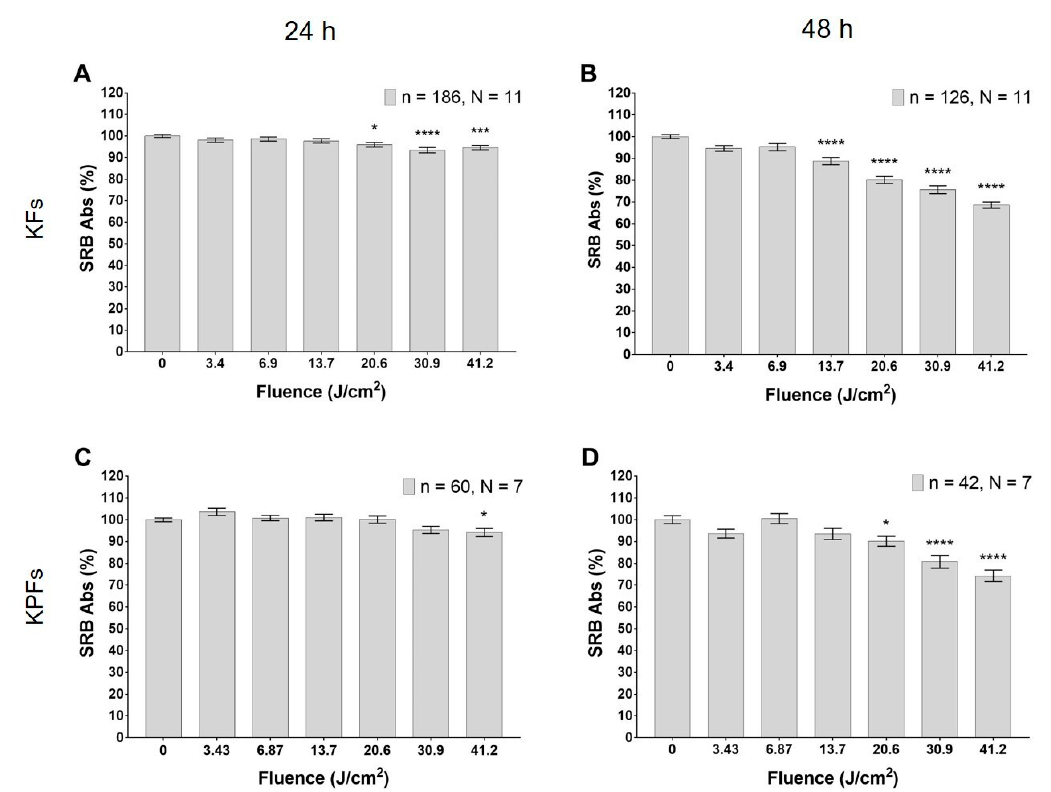
Figure 6. Effects of blue LED light on cell proliferation in human keloid fibroblasts. ( A , B ) Proliferation observed 24 and 48 h after the treatment in keloid fibroblasts, respectively. ( C , D ) Proliferation observed 24 and 48 h after the treatment in perilesional keloid fibroblasts, respectively. Data are expressed as mean ± SEM. Each measure is repeated in triplicate at 24 h and in duplicate at 48 h. Statistical analysis: * p < 0.05; *** p < 0.001; **** p < 0.0001 vs. control (not irradiated cells), one-way ANOVA followed by Dunnett’s multiple comparison test.